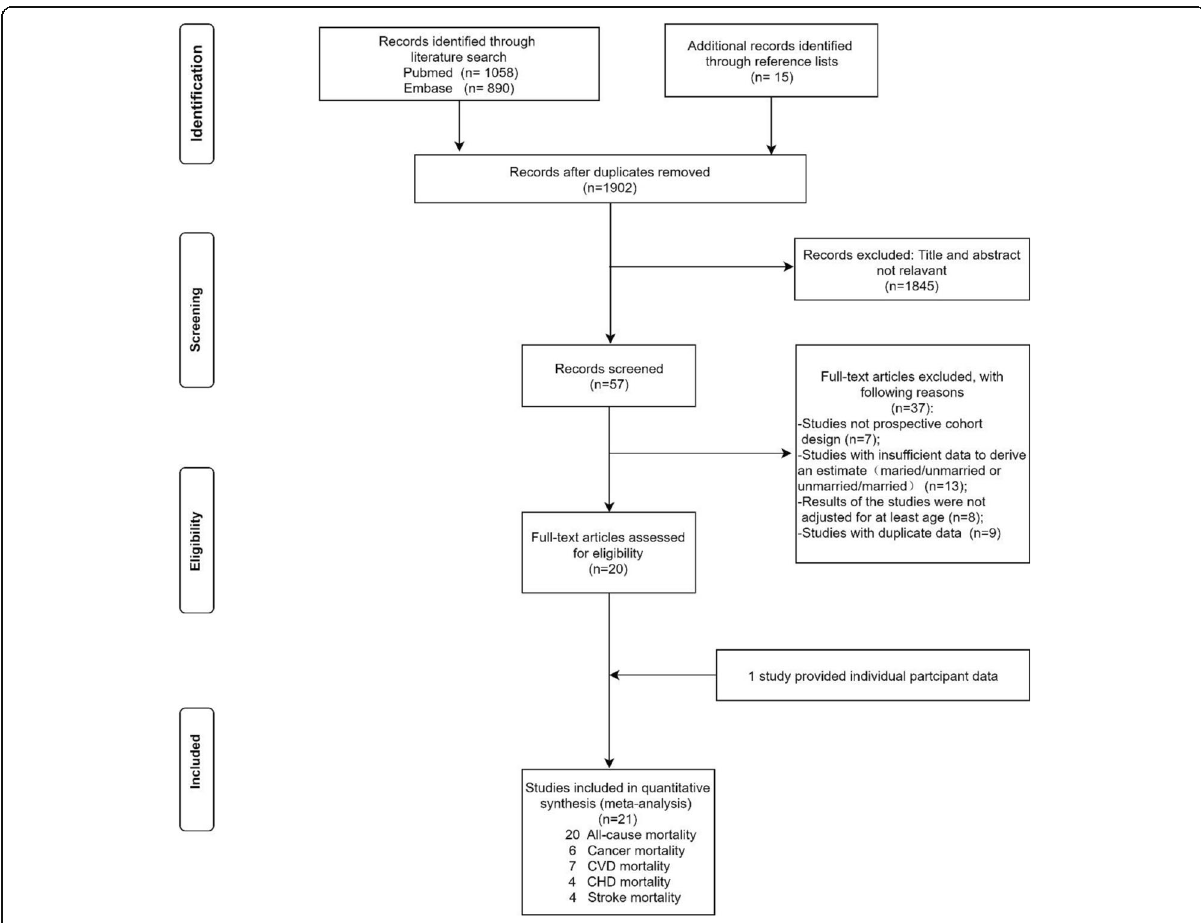
Fig. 1 Flowchart for study selection for the